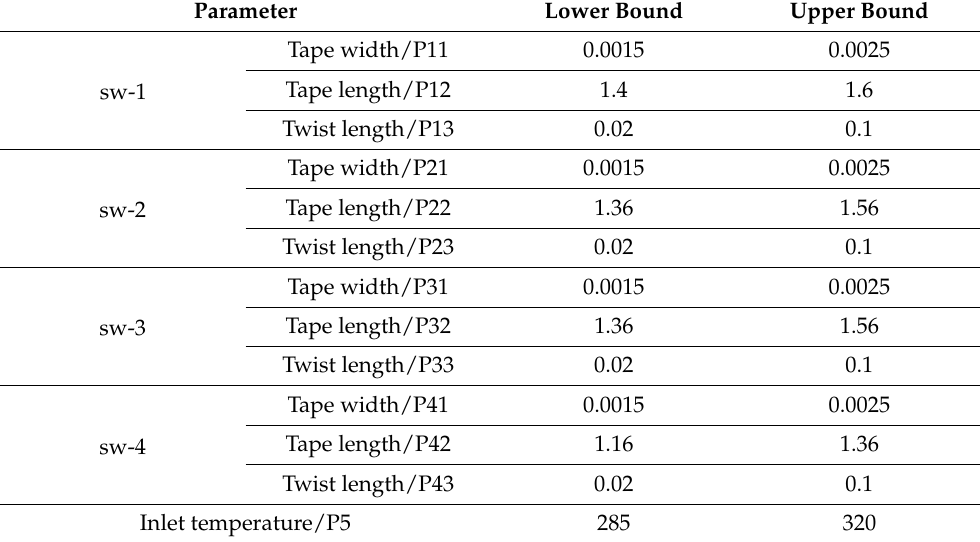
Table 3. Design parameters and their value